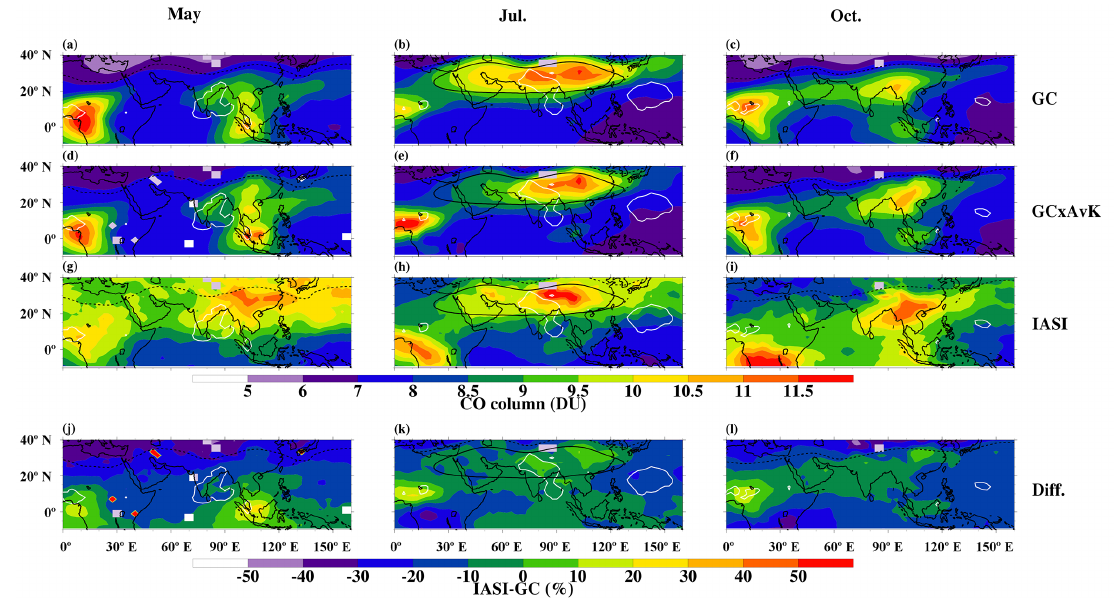
Figure 1. Distributions of UTLS (270–110hPa) CO columns: (a, b, c) GEOS-Chem, (d, e, f) GEOS-Chem smoothed with IASI AvK, (g, h, i) IASI and (j, k, l) relative differences between GC smoothed with IASI AvK and IASI. From left to right, panels correspond to monthly periods with (a, d, g, j) May, (b, e, h, k) July and (c, f, i, l) October. The white solid line represents the 2.5kgm − 2 s − 1 convective upward mass flux from GEOS-5 averaged over 350–150hPa. The black dashed line is the tropopause (2PVU) and the black solid line is the 12520m GH representing the AMA boundary at